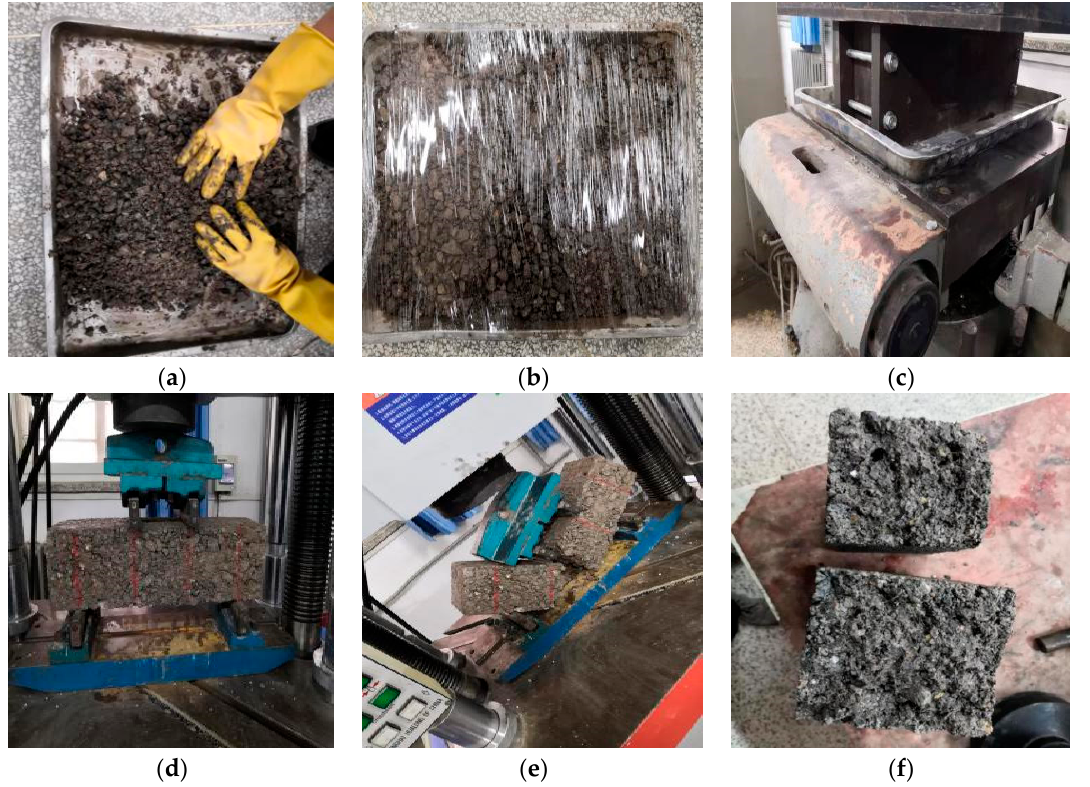
Figure 7. Flexural tensile strength test: ( a ) Mix; ( b ) Stuffy material; ( c ) Static pressure; ( d ) Test preparation; ( e ) In test; ( f ) After test.